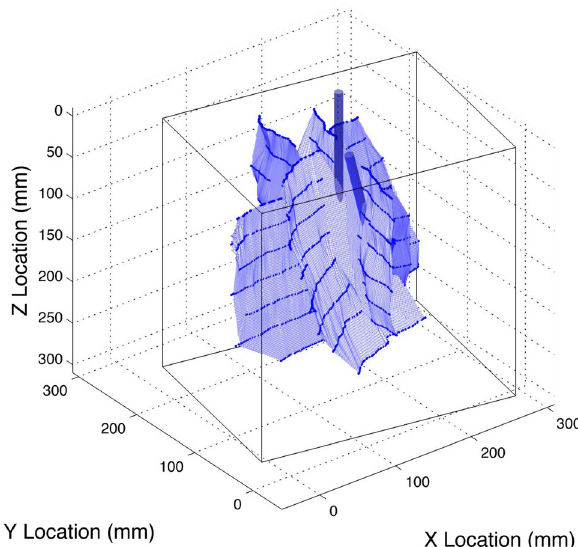
Fig. 11 All observed hydraulic fractures from slab photos. Dark blue circles represent the digitization of actual fracture locations from the images in Fig. 10. The light blue mesh is just an interpolated spline surface between these points